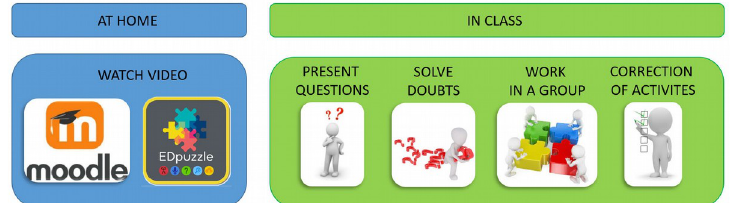
Figure 2. Process followed for mathematics lessons in the FC